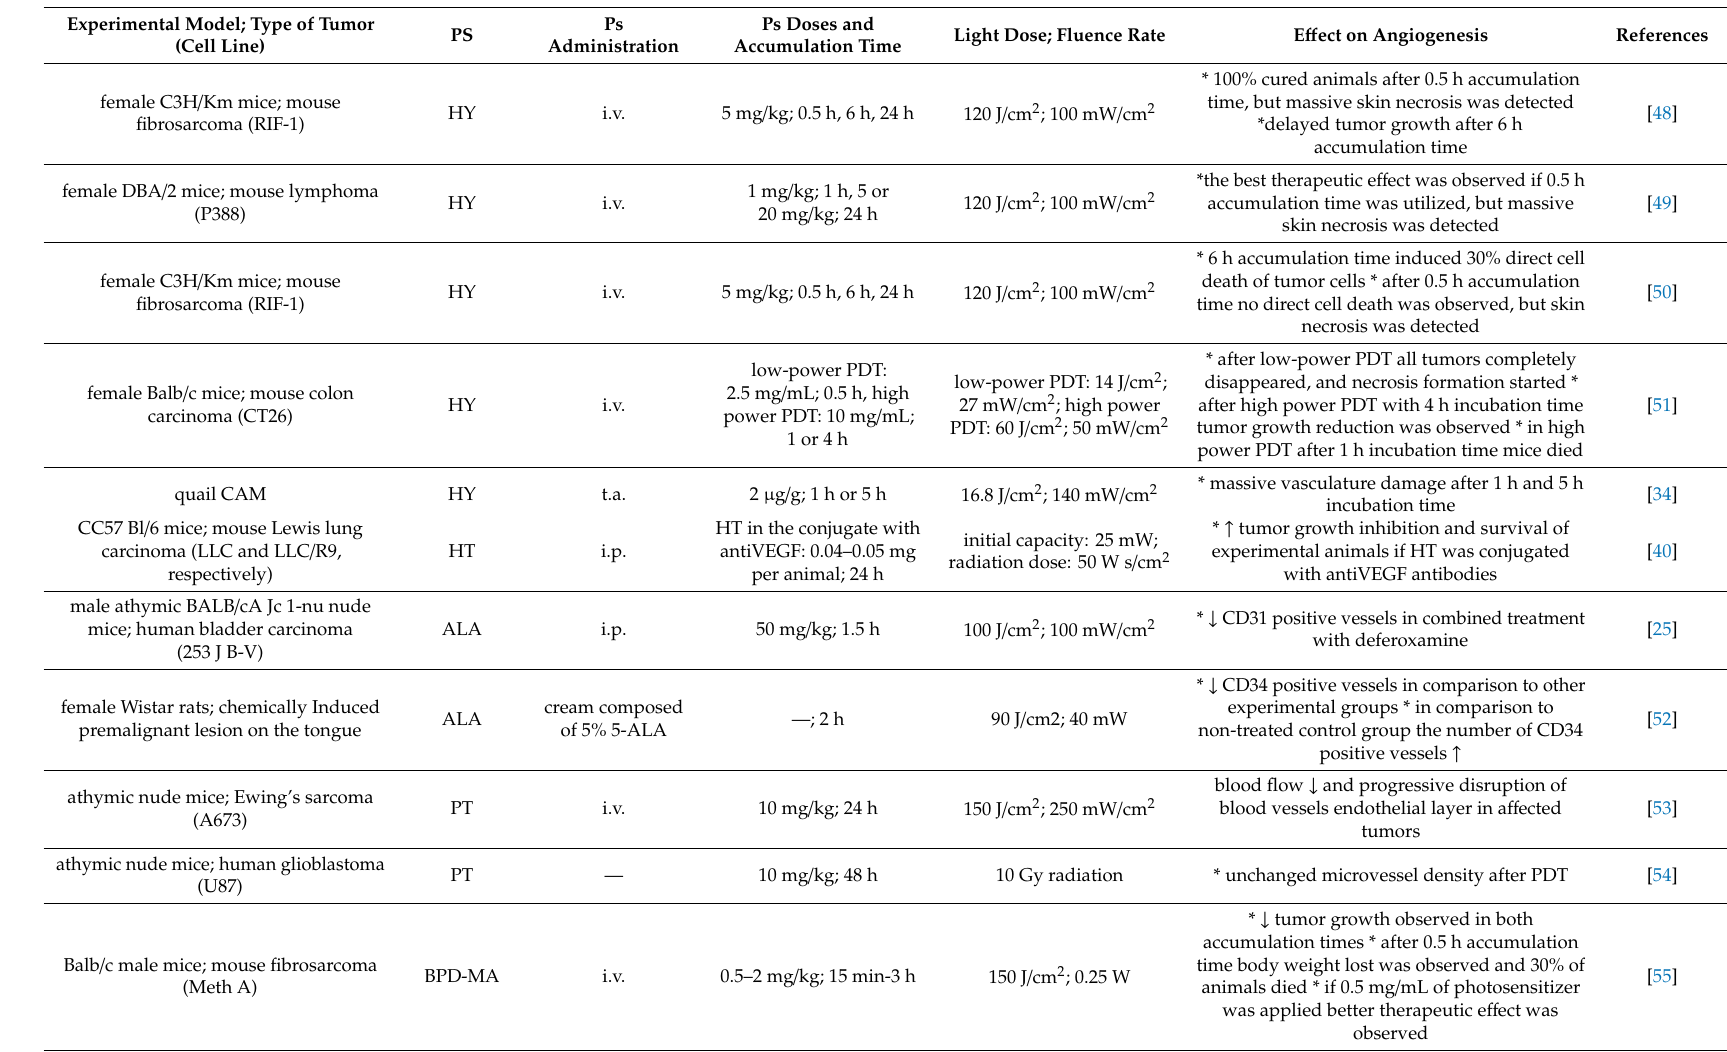
Table 2. In vivo experimental models utilized for PDT in relation to